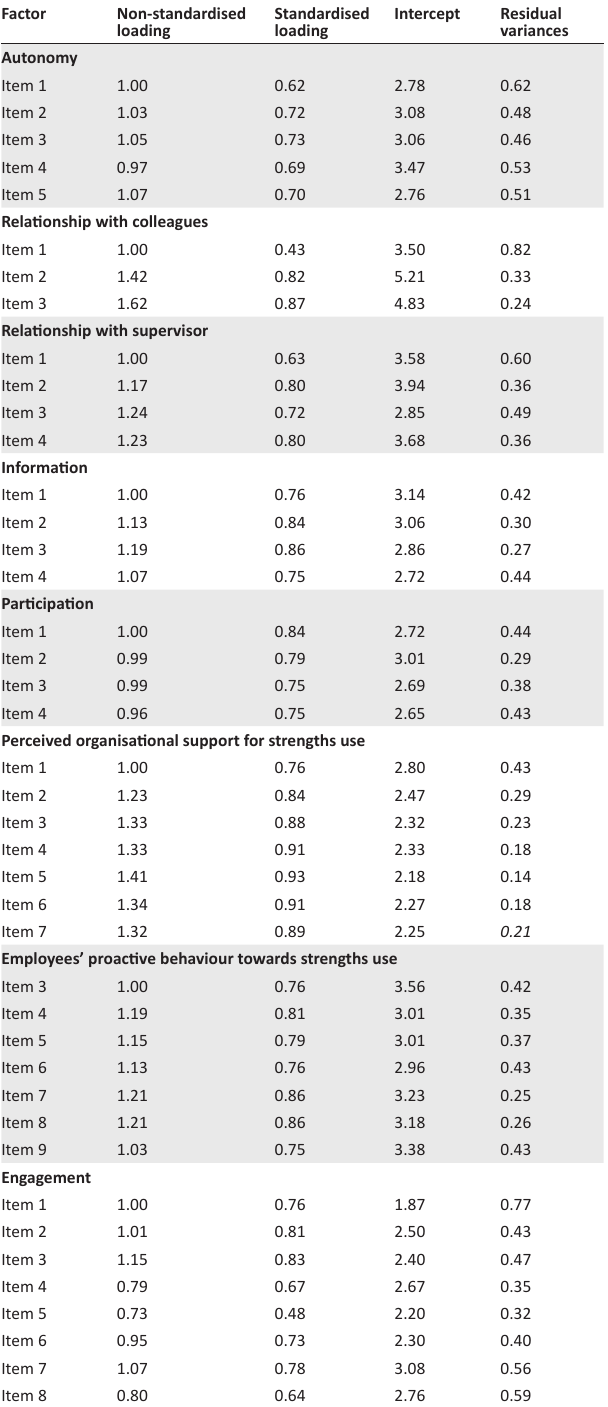
TABLE 2: Factor loadings, intercept and residual variances of the measurement model. Factor Non-standardised